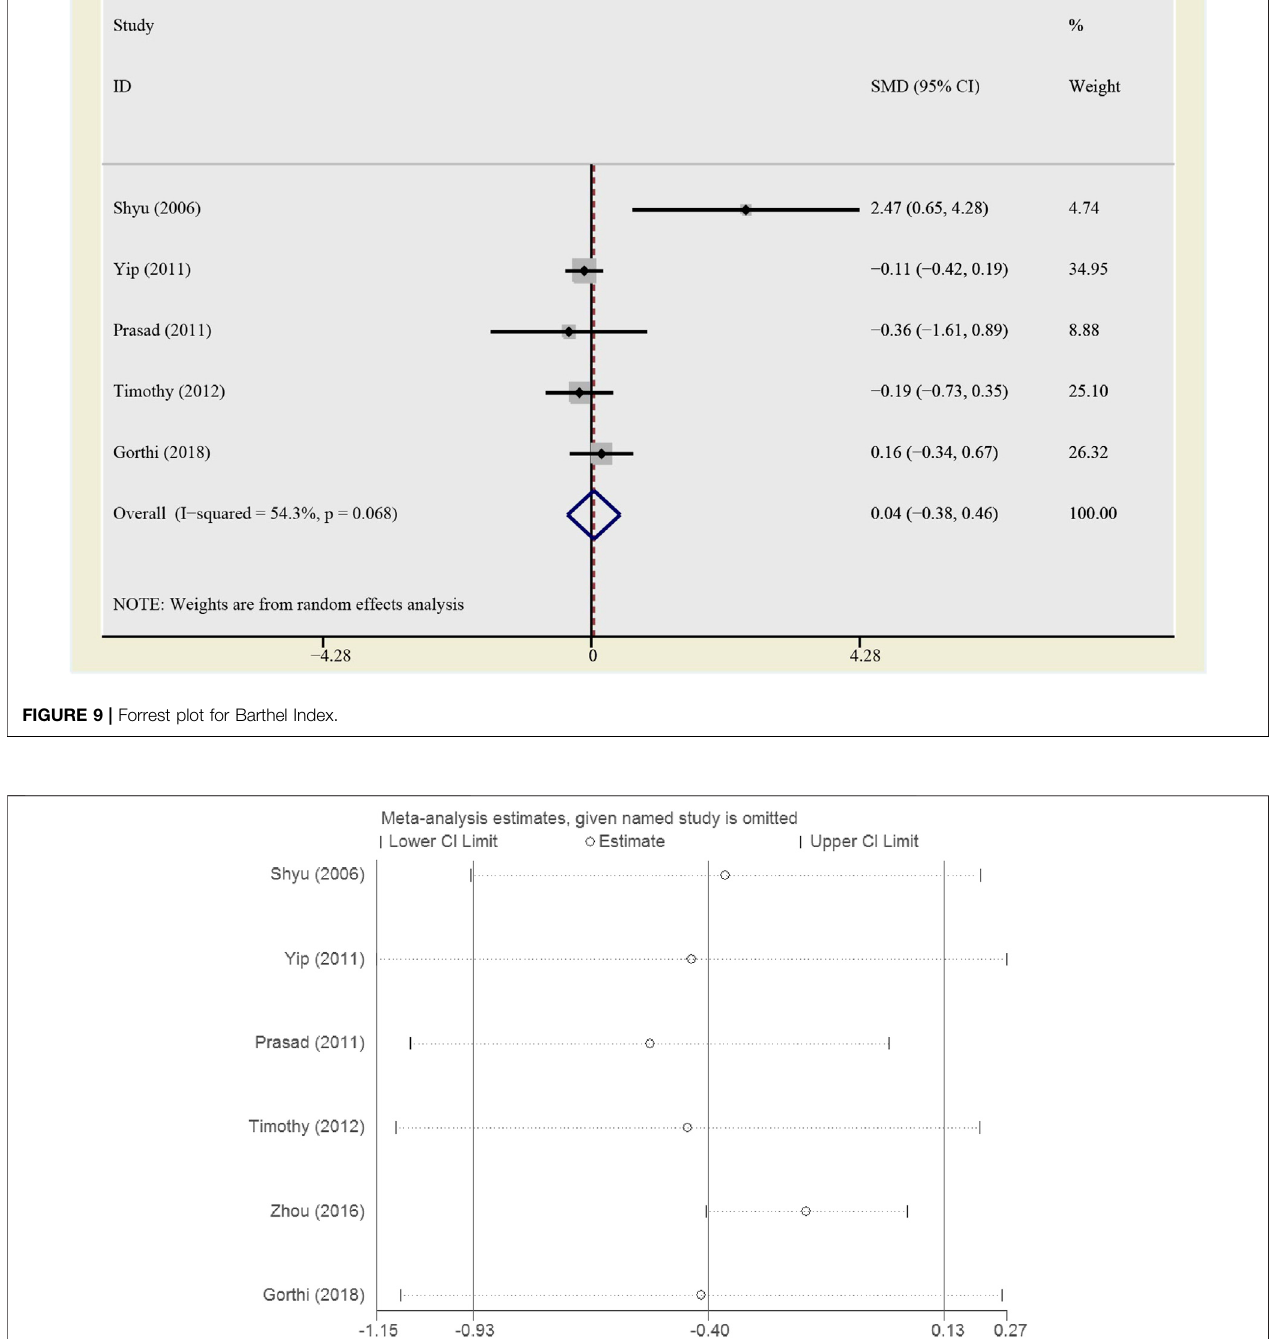
Frontiers in Pharmacology |